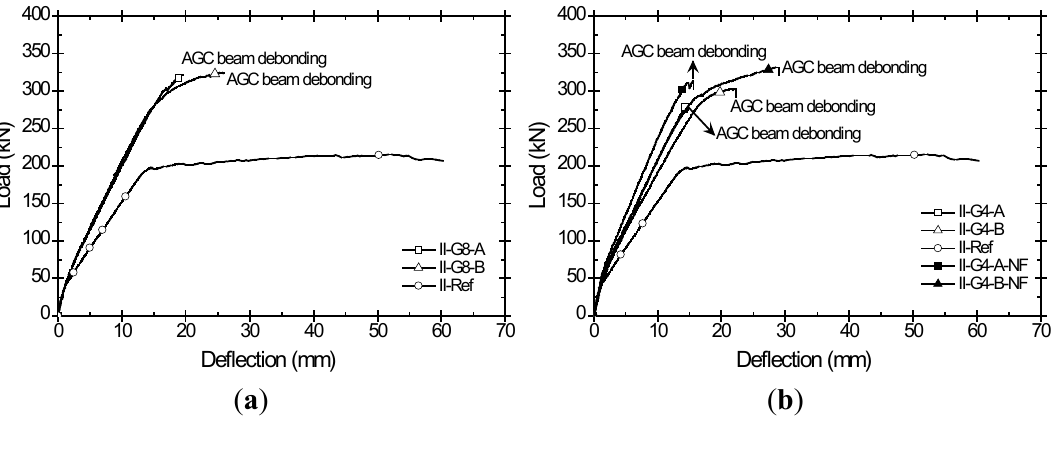
Figure 8. Load-deflection responses of beam specimens with ( a ) glass-fiber of W80-F20 and ( b ) glass-fiber of